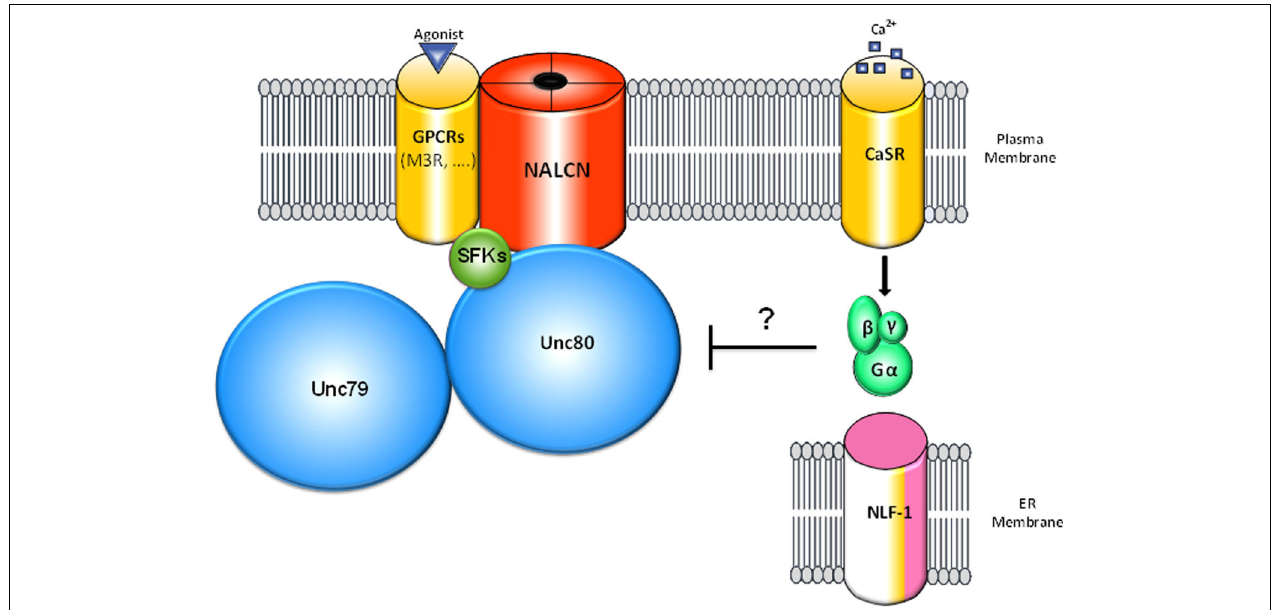
FIGURE 2 | Schematic representation of the NALCN channelosome. The NALCN ion channel interacts with the M3 muscarinic receptor (M3R) that activates the channel through a G protein-independent and Src Family of Tyrosine Kinases (SFK)-dependent pathway upon activation by acetylcholine (Swayne et al., 2009). UNC-80 interacts with NALCN and SFKs and acts as a scaffolding protein (Wang and Ren, 2009; Lu et al., 2010). In addition, UNC-80 is involved in the expression levels of NALCN and UNC-79 as well as their neuronal localization (Jospin et al., 2007;